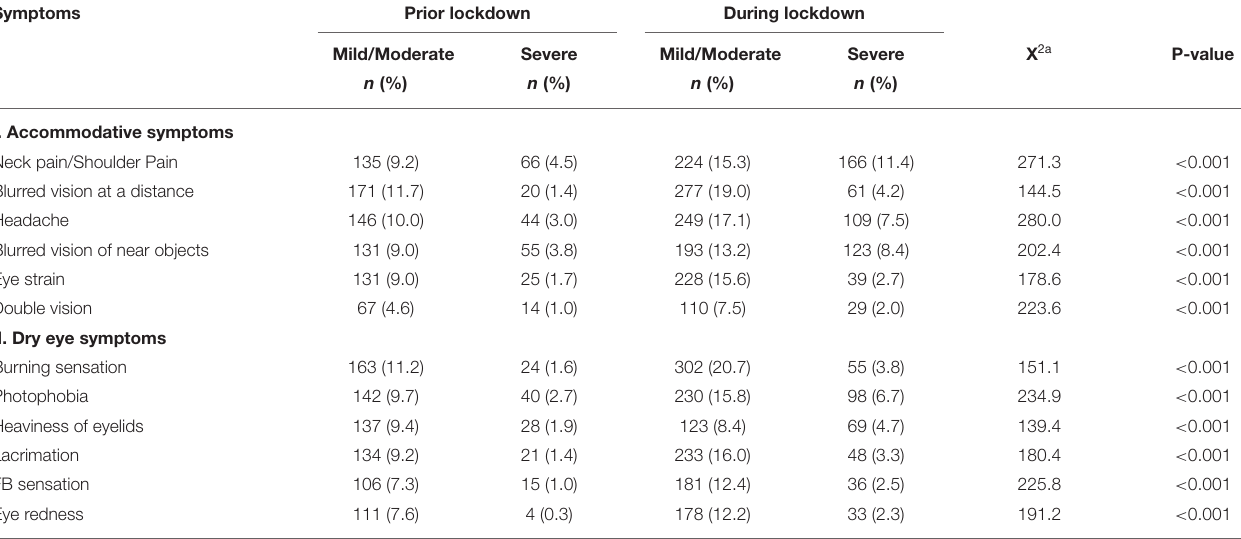
TABLE 2 | Self-reported symptoms prior and during lockdown (value in % of total sample) with Chi-square test of